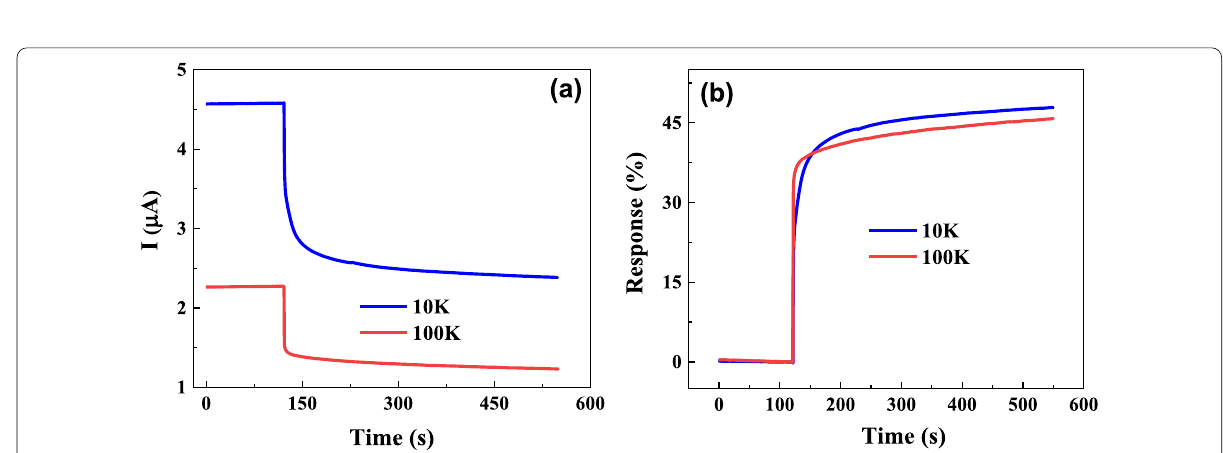
Fig. 6 Time dependence of electrical current ( a ) and response ( b ) for SUDHL8 cancer cells with different concentrations of 10 K and 100 K